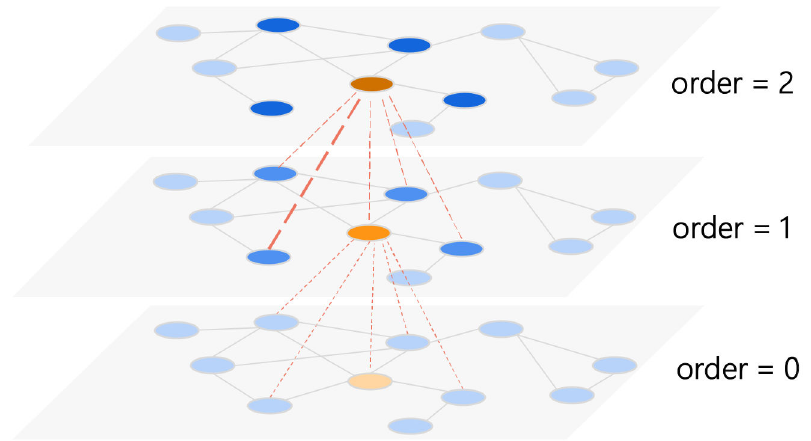
Figure 6. A GCN aggregates neighborhood information to obtain the spatial dependence between nodes (order = 1, the node aggregates its first-order neighbors; order = 2, the node aggregates its second-order